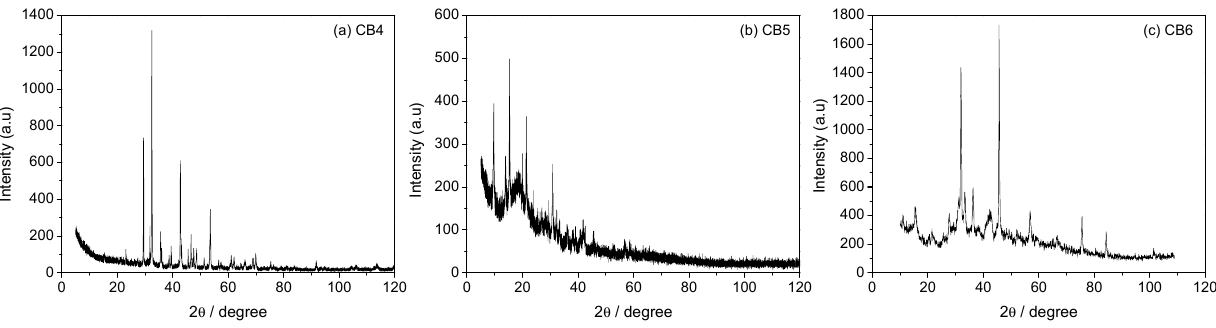
Figure 10. XRD patterns of ( a ) CB4, ( b ) CB5, and ( c ) CB6 products under atmospheric pressure.